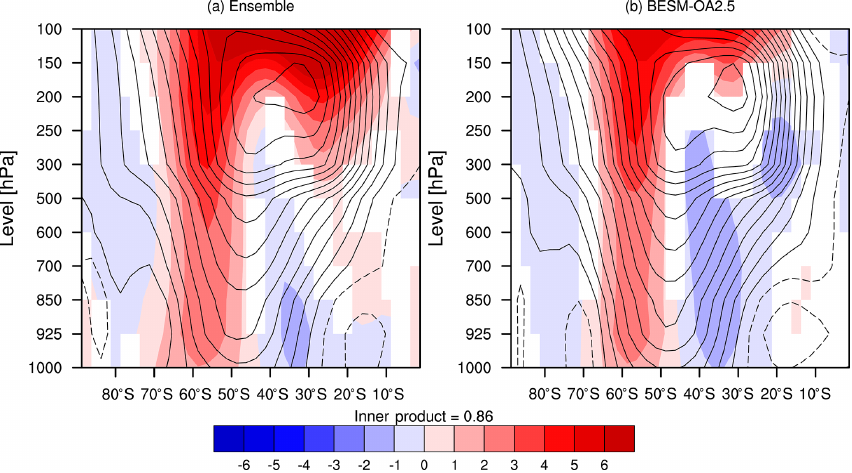
Figure 12. Vertical profile of the difference (averaged over years 120–150) in the zonal wind (ms − 1 ) between the two scenarios (abrupt4xCO2 minus piControl; shaded) and the piControl conditions (contours) for (a) the ensemble of CMIP5 models and (b) BESM- OA2.5. The white areas have confidence levels less than